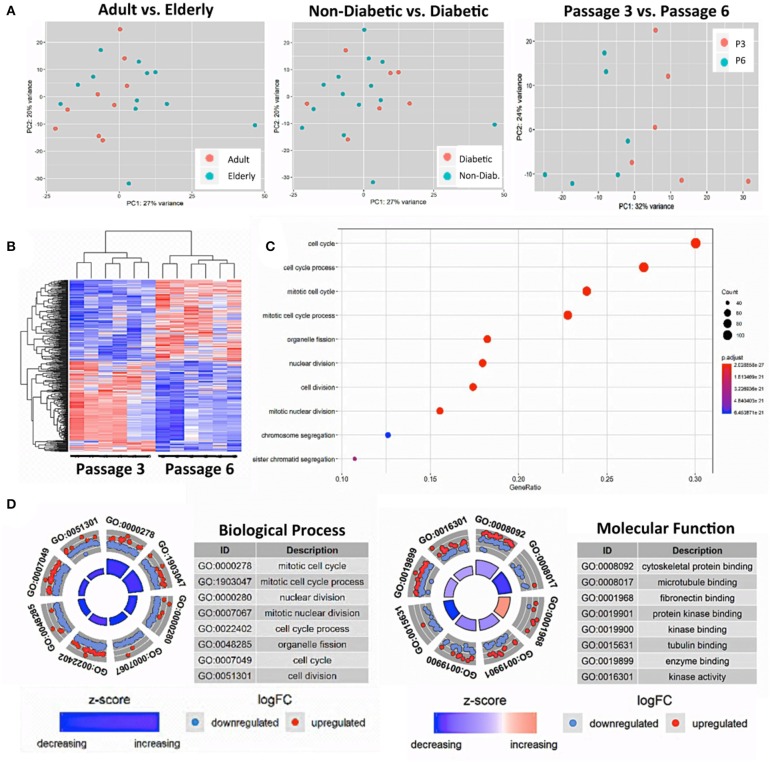
Gene-expression-profiling of BMSCs with RNA-sequencing. (A) Principle component analysis (PCA) was employed for the visualization of group separation. Groups were stratified either according to donor age (left panel; n = 9 adult vs. n = 12 elderly donors), health status (central panel: n = 14 non-diabetic vs. n = 7 diabetic donors), and passage number (right panel; n = 6 random donors at passage 3 vs. 6). The PCA showed clear separation when comparing passage 3 vs. 6 (right panel), but no separation for the comparison of adult vs. elderly or diabetic vs. non-diabetic donors, with a random dot distribution throughout the graph. (B–D) passage 3 vs. 6 comparisons: (B) hierarchical clustering heat map with expression values sorted according to donor (rows) and gene (columns), where low expression is denoted by blue and high expression by red; (C) gene ontology (GO) enrichment analysis, with the “Top 10 Results” for changes in biological process (e.g., cell cycle, nuclear and cell division, and chromosome segregation) shown on the left y-axis and the size of the dots representing the counts of genes involved, while the color of the circle (scaled blue/lowest to red/highest) indicates significance expressed as adjusted p-value. (D) Combined David and GO “Top 8 Results” database analysis for changes in biological process (left panel; e.g., mitotic cell cycle and nuclear division) and molecular function (right panel; e.g., cytoskeletal protein binding and microtubule binding), with the z-score indicating the overall decrease or increase in expression for certain GO terms and the log-FC analysis indicating the actual number of down- or up-regulated genes within a certain GO term.